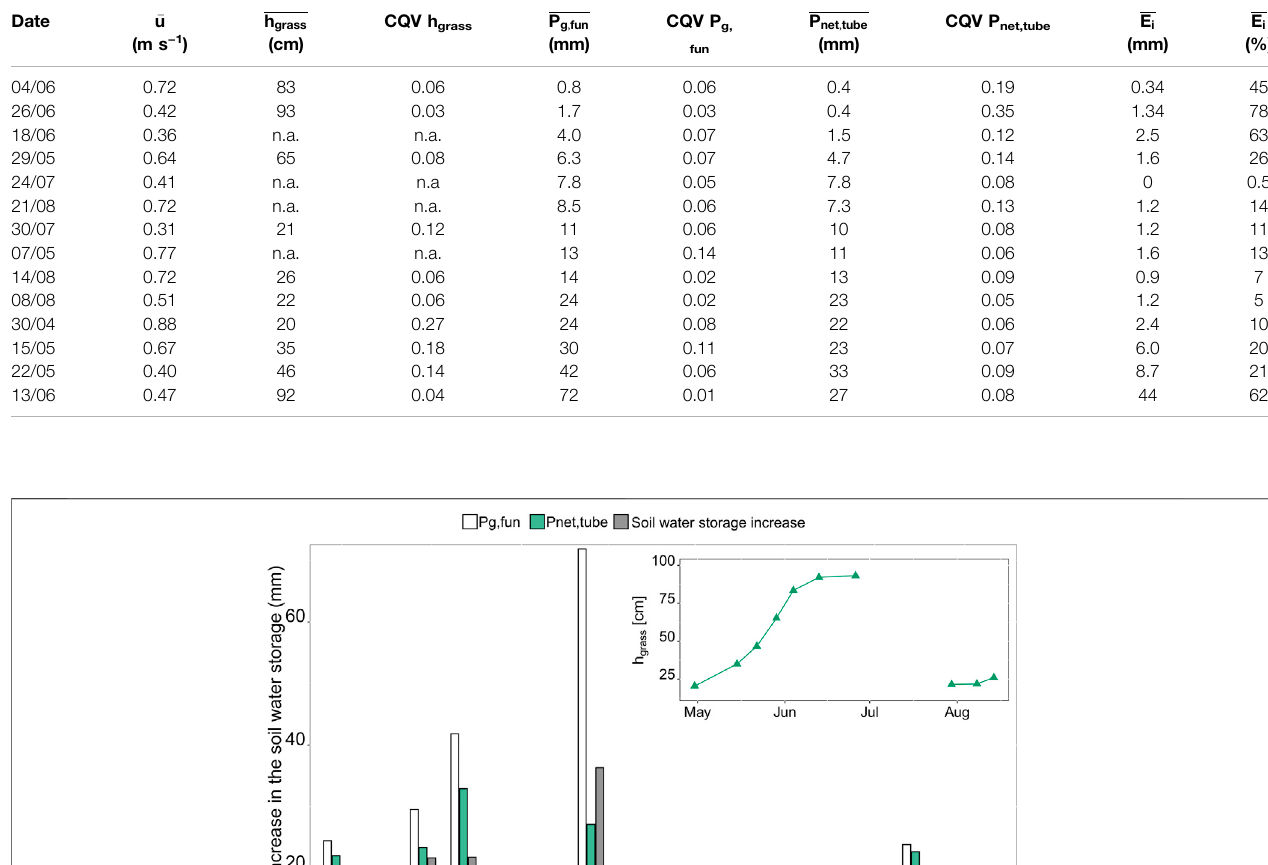
TABLE 4 | Overview of the properties of the net precipitation sampling periods during the covered period in 2019. Weeks without rain are not listed. n.a. indicates missing data. Variables shown are: recorded weekly average of wind speed ( (cid:1) u ) by meteorological station together with manually sampled weekly average of cumulative funnel